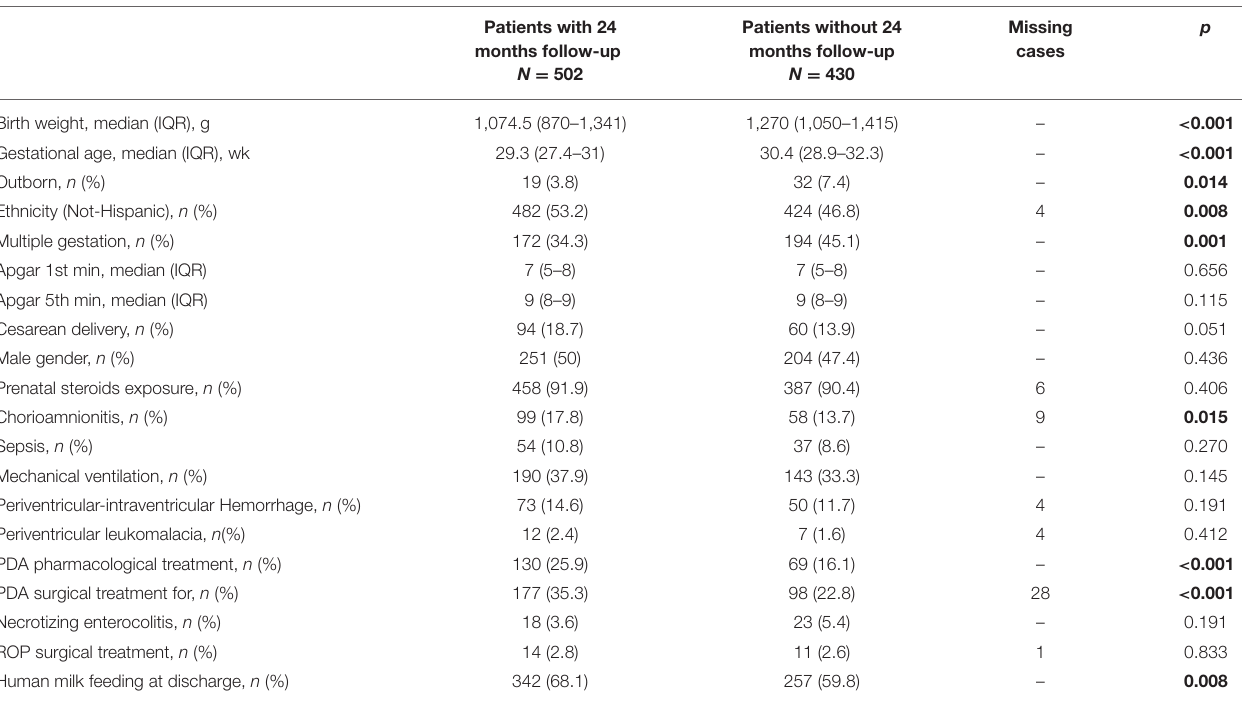
FIGURE 2 | Enrollment flow diagram. TABLE 1 | Characteristics of infants undergoing or not a 24 months neuro-developmental